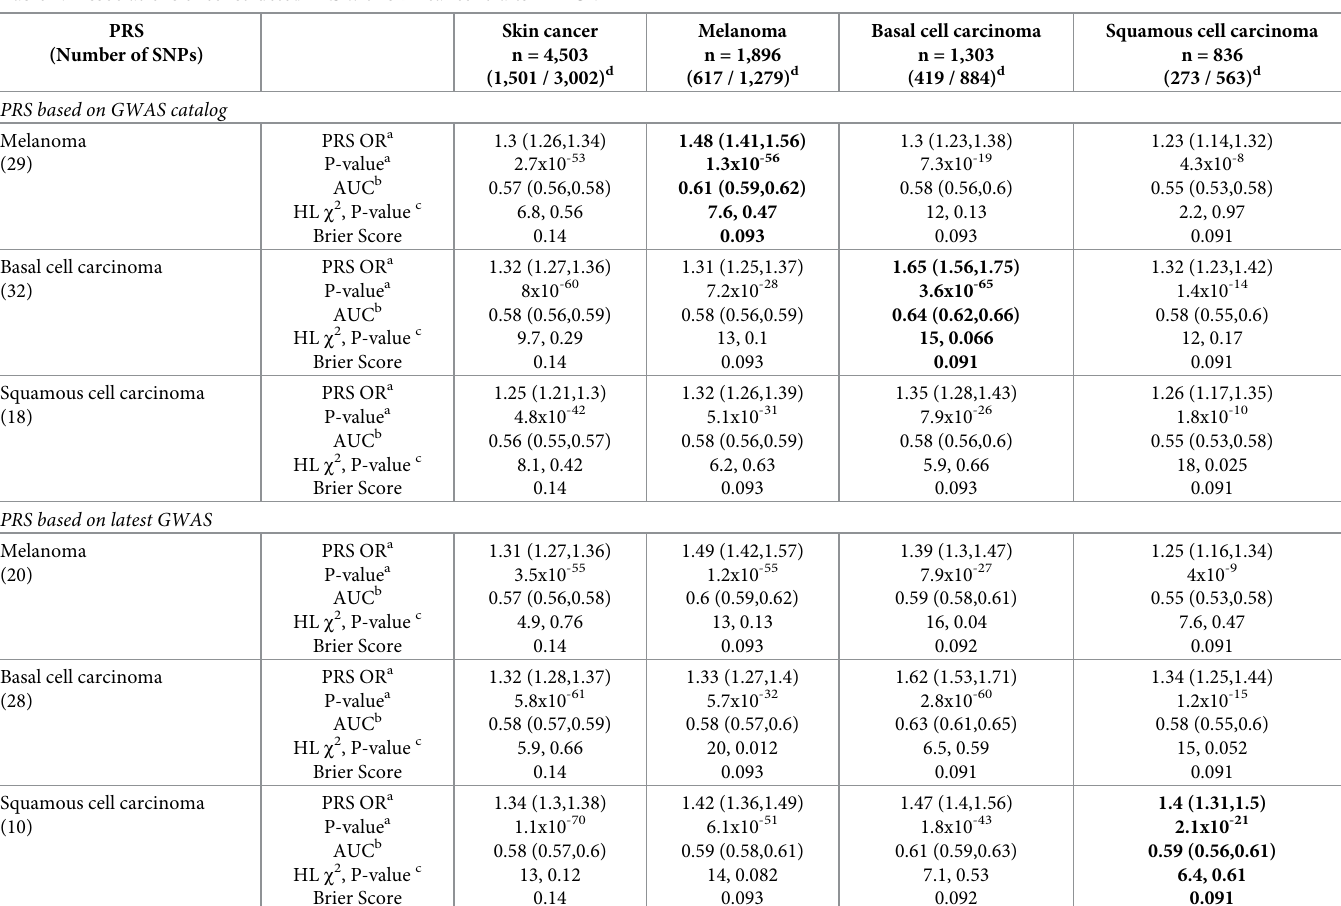
Table 2. Associations of constructed PRS with skin cancer traits in